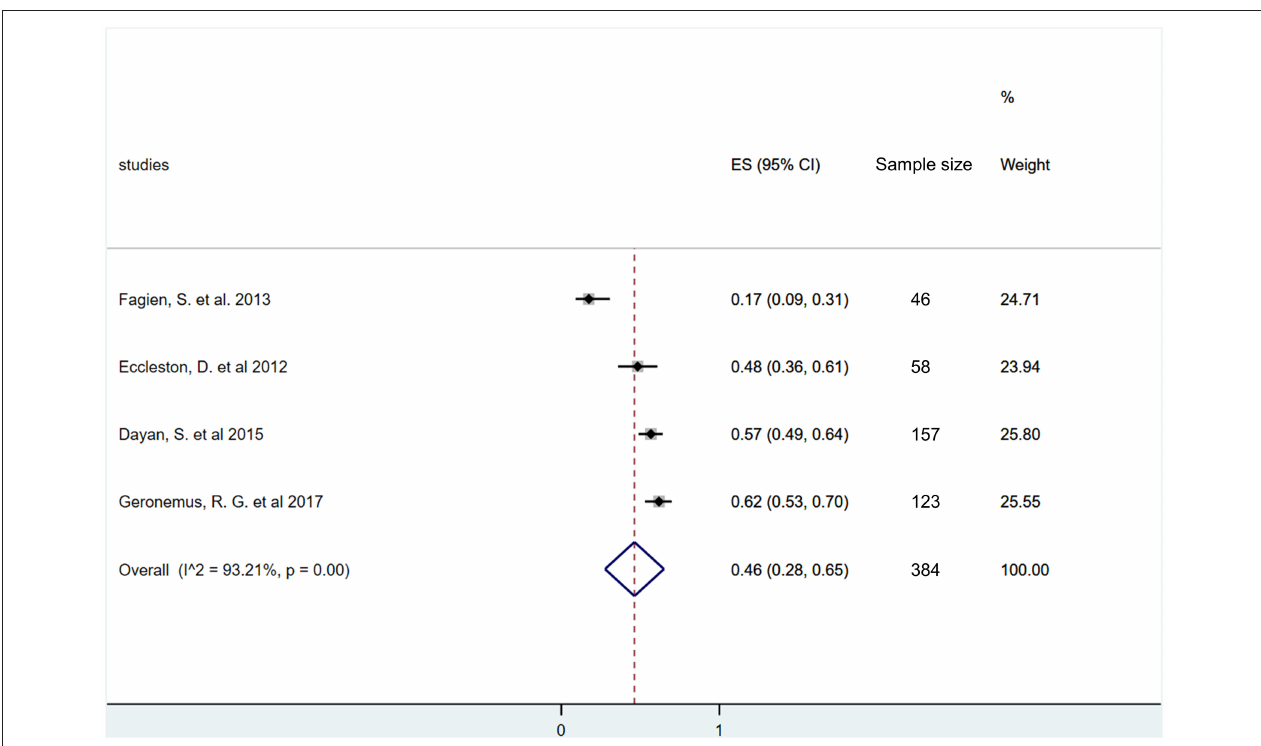
FIGURE 7 | Estimate of overall rate of responders at 12 months after treatment. Overall, 46% (95% CI: 28–65%) of included participants had at least one grade improvement on a validated lip fullness scale after 12 months of initial